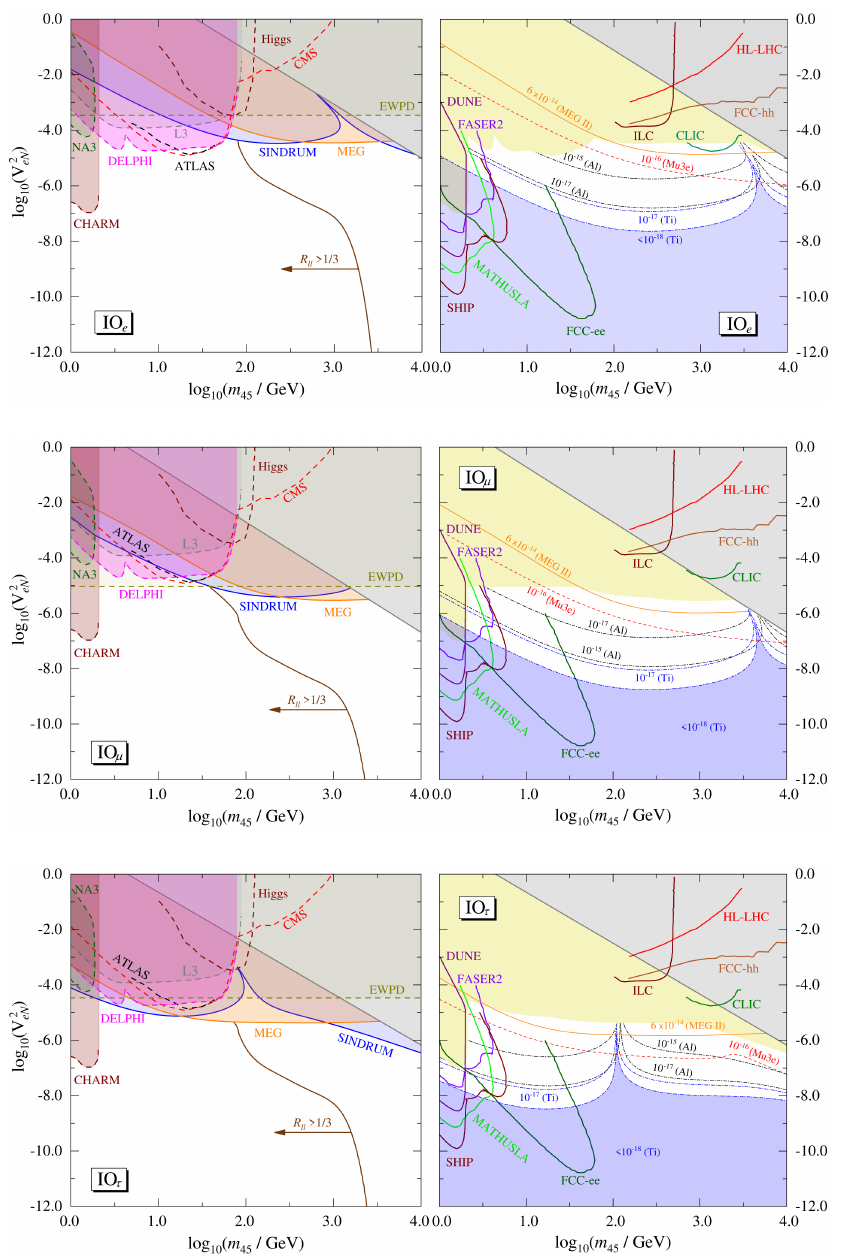
Figure 9 . The same as in figure 8 for IO e , IO µ and IO τ